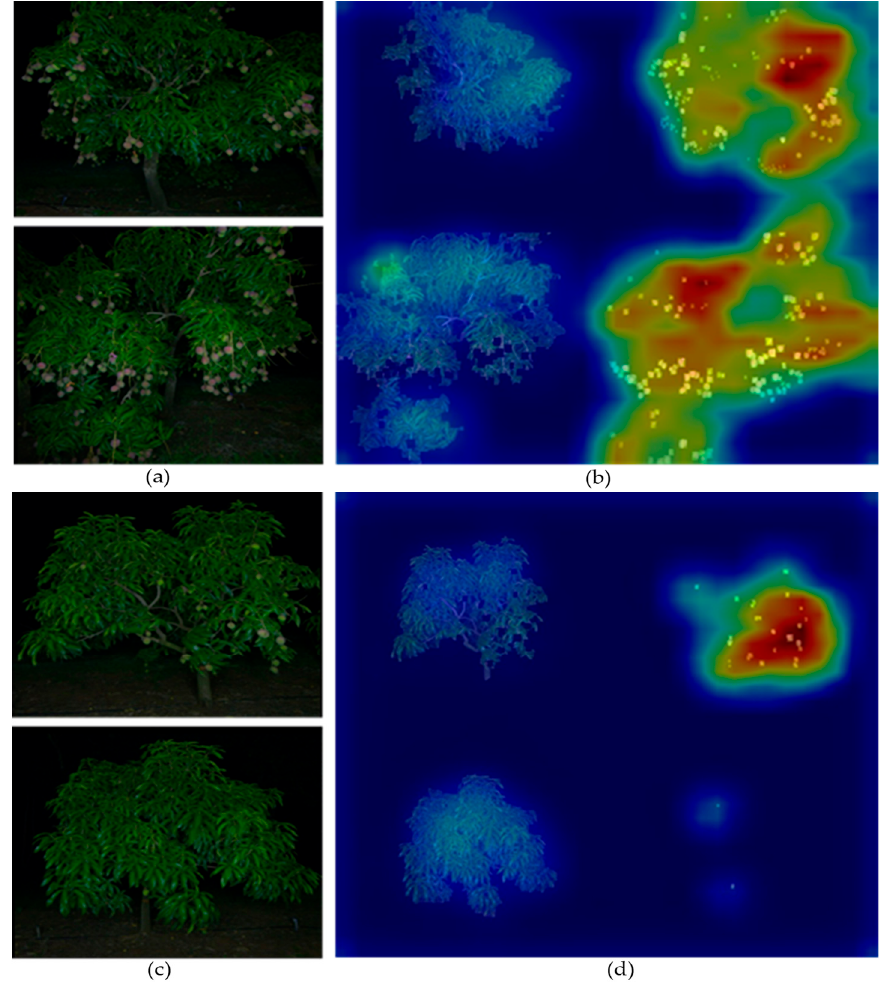
Figure 9. Grad-CAM visualization of the activation heatmap of the final convolutional layer of Xception_yield model on the reconstructed input images. Panels ( a , c ) present the raw images of two sides of a tree while ( b , d ) present activation heat-maps of canopy and fruit regions of reconstructed images, respectively. ( a ): Typical result for tree with fruit on both sides of the canopy. ( b ): Typical result for tree with fruit on one side of canopy.